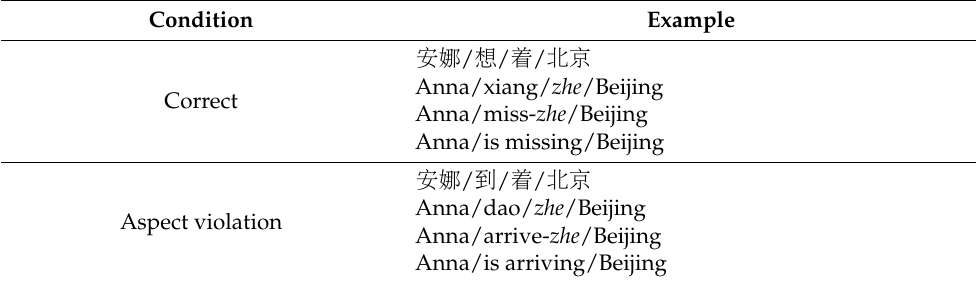
Table 3. Examples of sentences in each